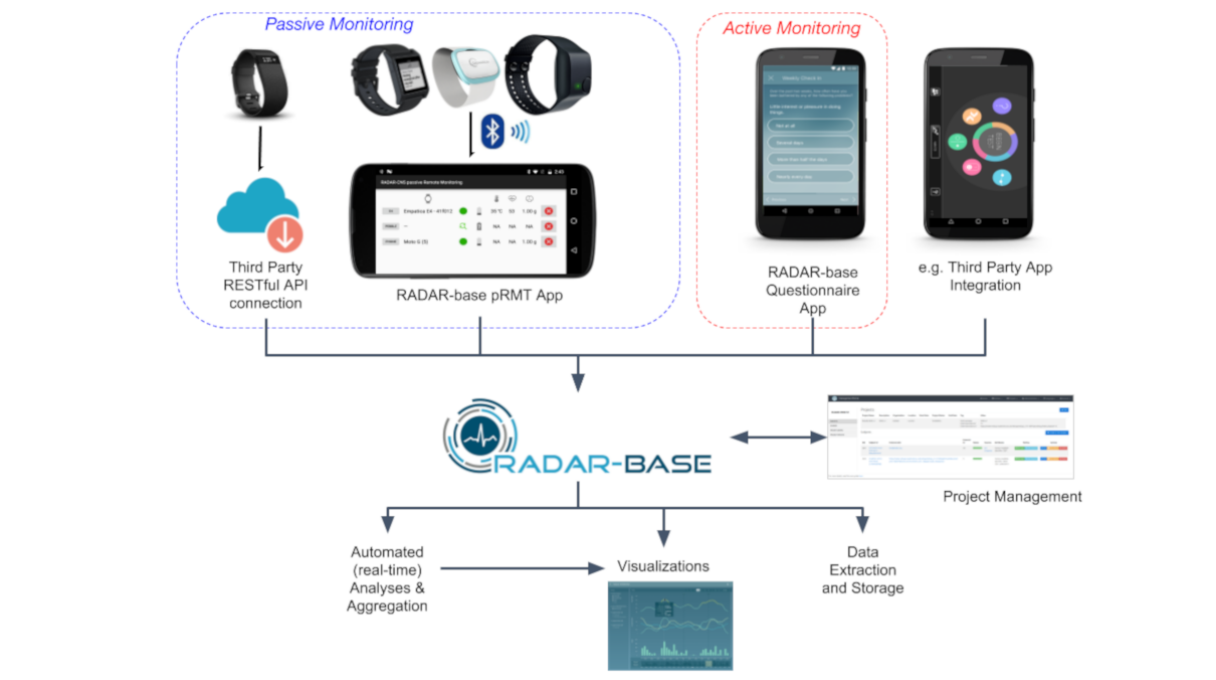
Figure 2. Current data sources: Empatica E4, Pebble 2, Fitbit, Biovotion, Faros, active Remote Monitoring Questionnaire app, and passive Remote Monitoring